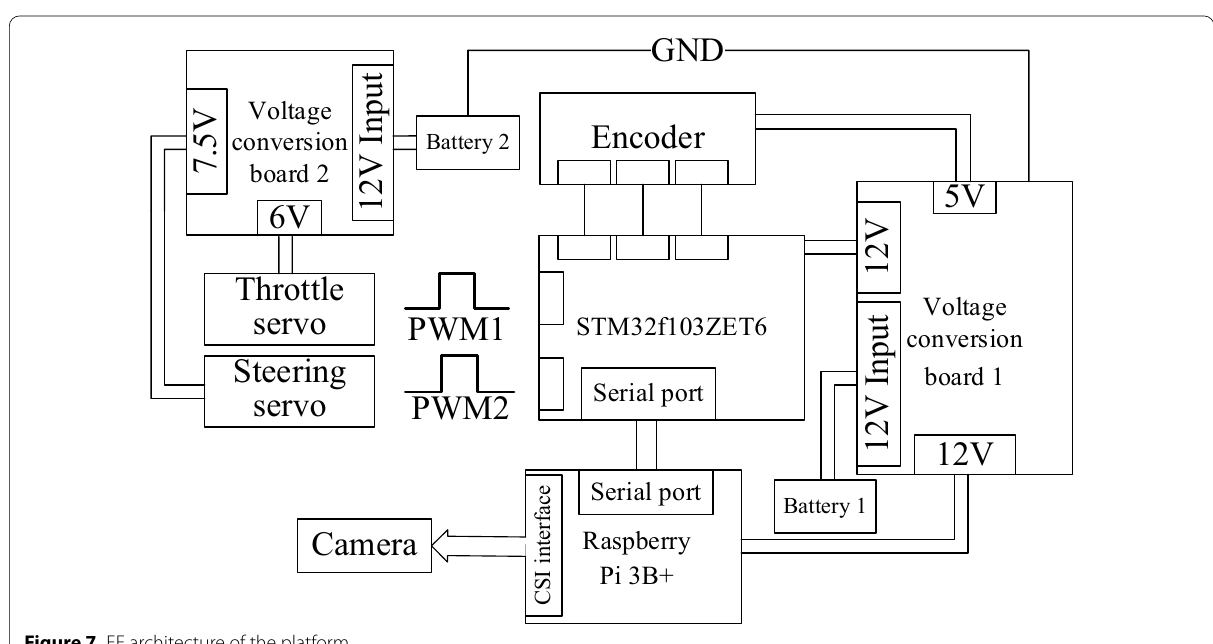
Figure 7 EE architecture of the